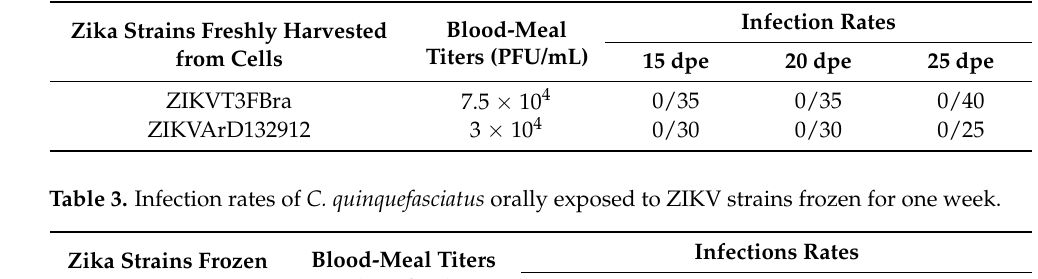
Table 2. Infection rates of C. quinquefasciatus orally exposed to ZIKV strains freshly harvested from cells. Infection Rates Blood-Meal Zika Strains Freshly Harvested Titers (PFU/mL) from Cells